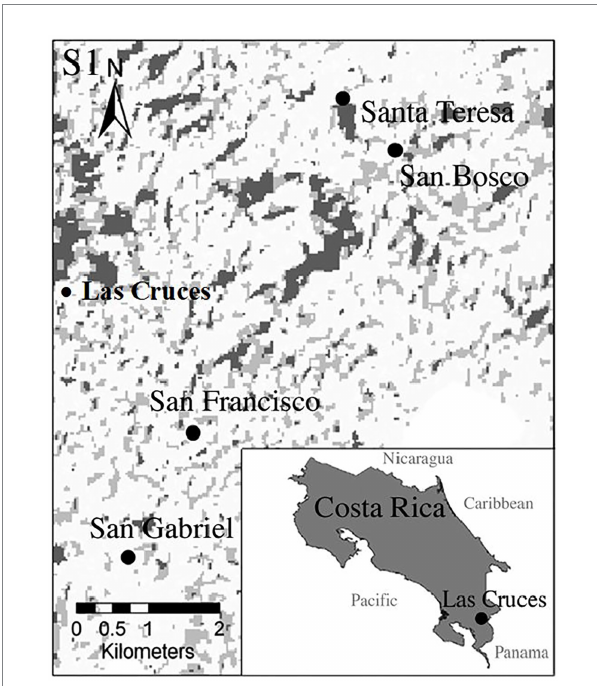
FIGURE 1 Map of the study area. Dark gray represents arboreal cover (forest fragments, riparian strips, and remnant trees), gray represents second growth with few trees, and white represents human-dominated habitats (pastures, coffee plantations, other agriculture, and